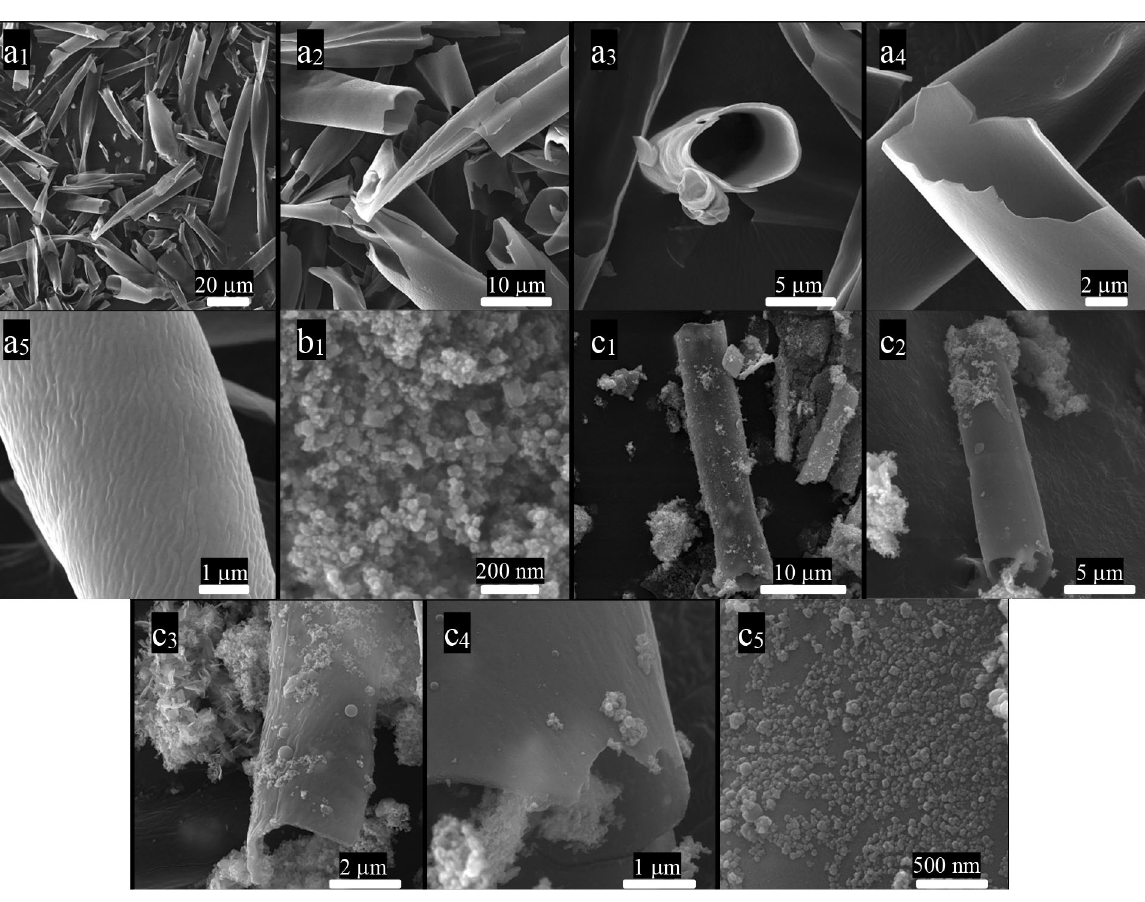
Figure 3. FE-SEM micrographs of FCMT ( a 1–5 ), CuCo 2 S 4 ( b 1 ), and FCMT/CuCo 2 S 4 ( c 1–5 )